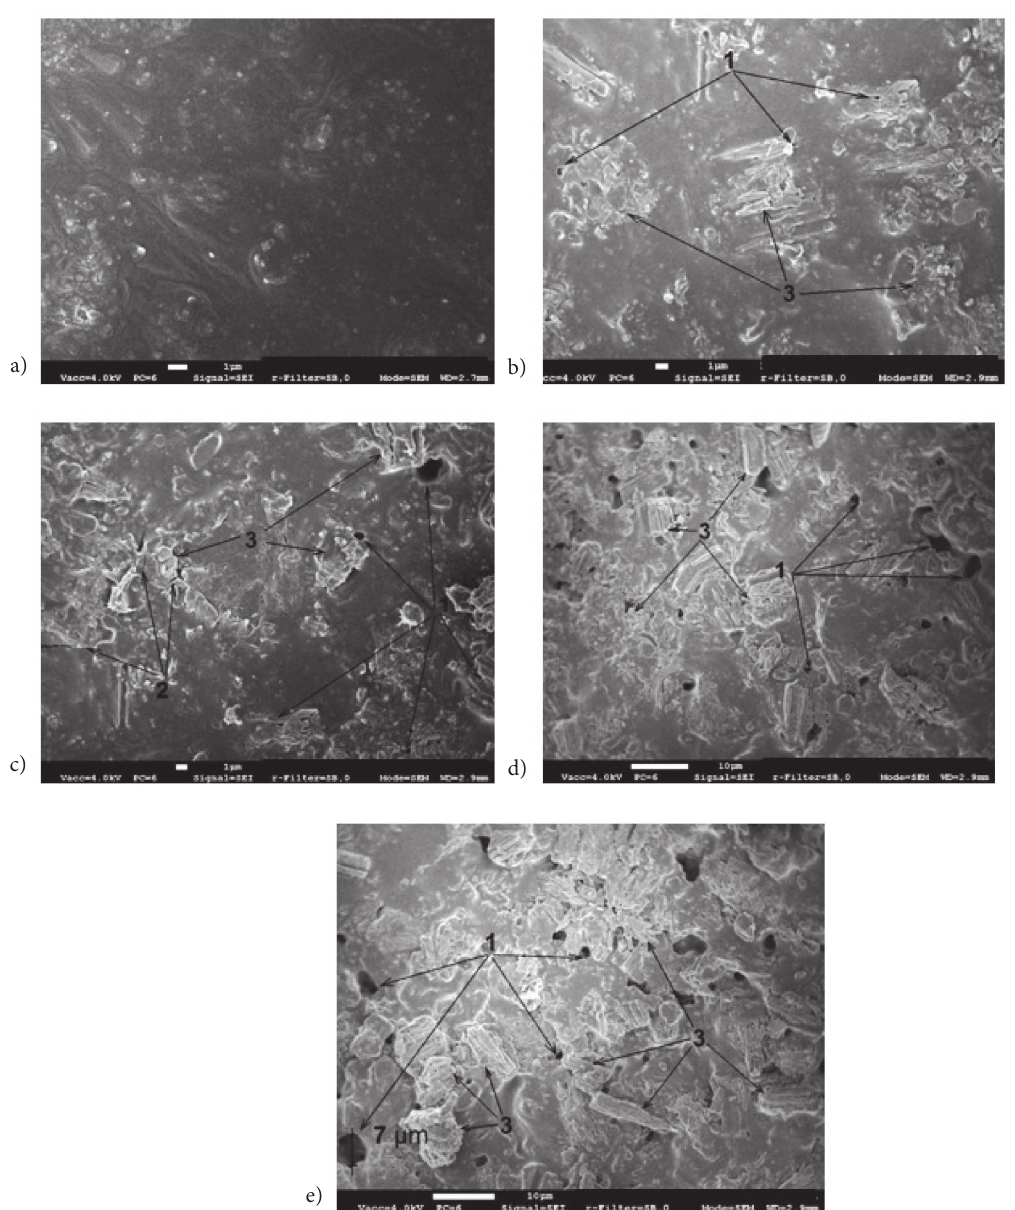
Figure 3. Images of microstructure of samples with STD05 paint coating: a – dry paint coating surface; b – paint coating surface after 15 cycles of treatment under I regime: 1 – cavity, 3 – precipitate; c – paint coating surface after 30 cycles of treatment under I regime: 1 – cavity, 2 – cracks, 3 – precipitate; d – paint coating surface after 45 cycles of treatment under I regime: 1 – cracks, 3 – precipitate; e – paint surface after 60 cycles of